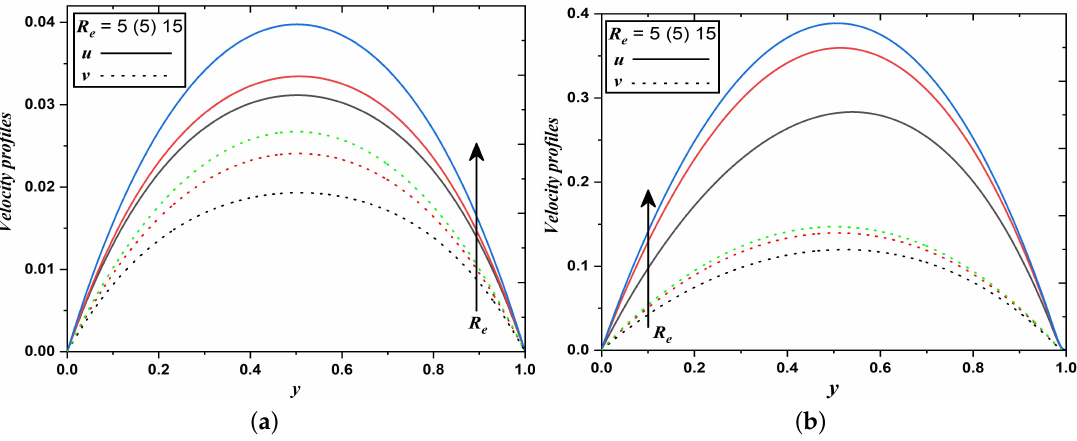
Figure 4. Velocity profiles when Reynolds number varies (Case 1 & 2).